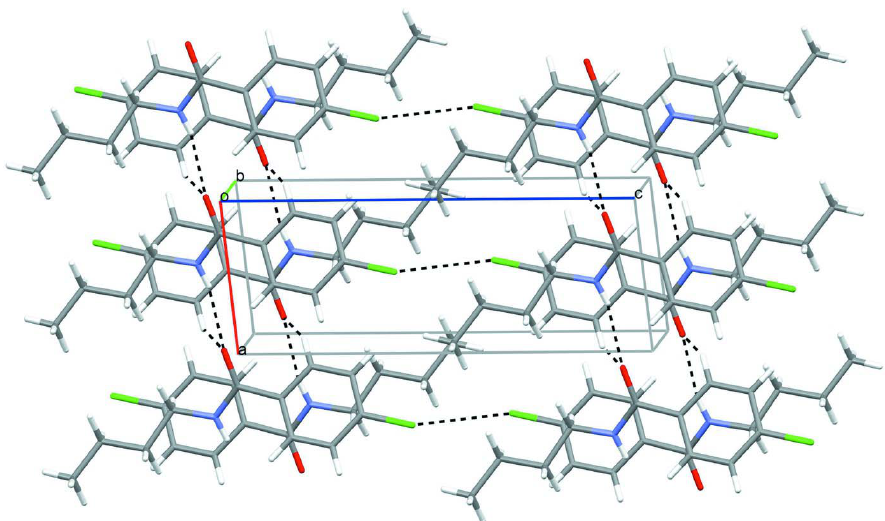
Figure 3 Crystal packing of I viewed down the b